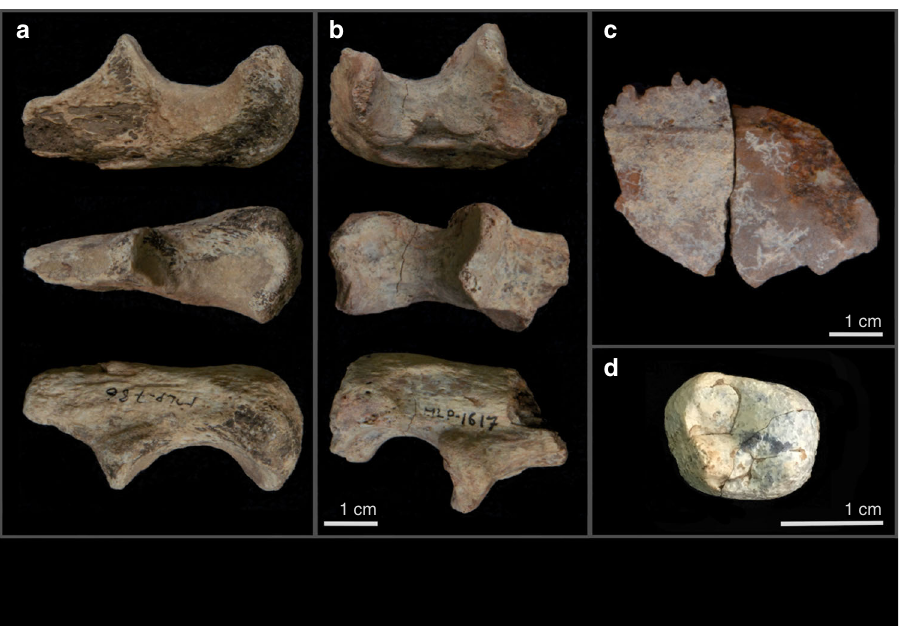
Fig. 3 Hominin remains from the MLP area. a , b are left and right proximal ulnae (MLP-786 & MLP-1617, respectively from two different localities, thus not from the same individual); c = calvarium fragment (MLP-1469); d = a diagnostic and complete upper second molar crown